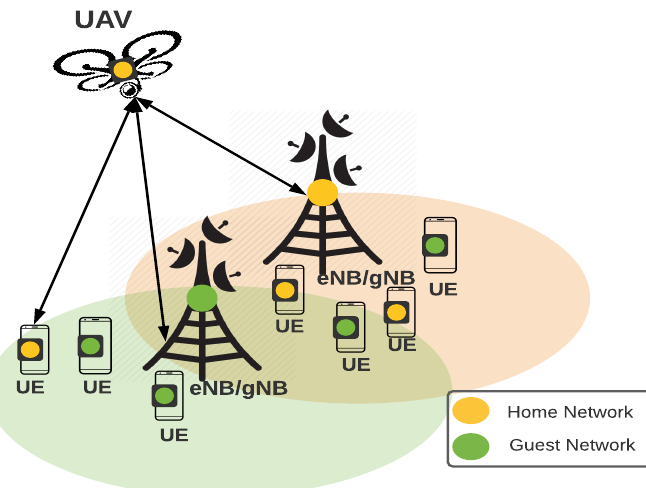
Figure 2. The cooperative service provisioning